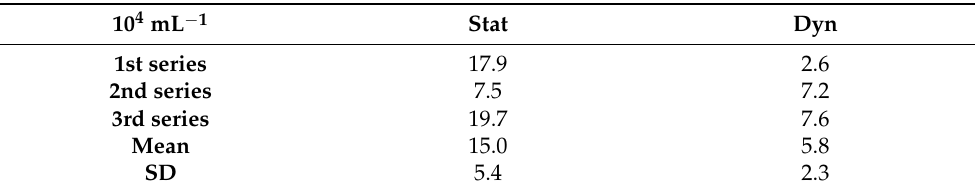
Table 2. Cell number within one matrix from each condition and each campaign, and mean and standard deviation over the three series.